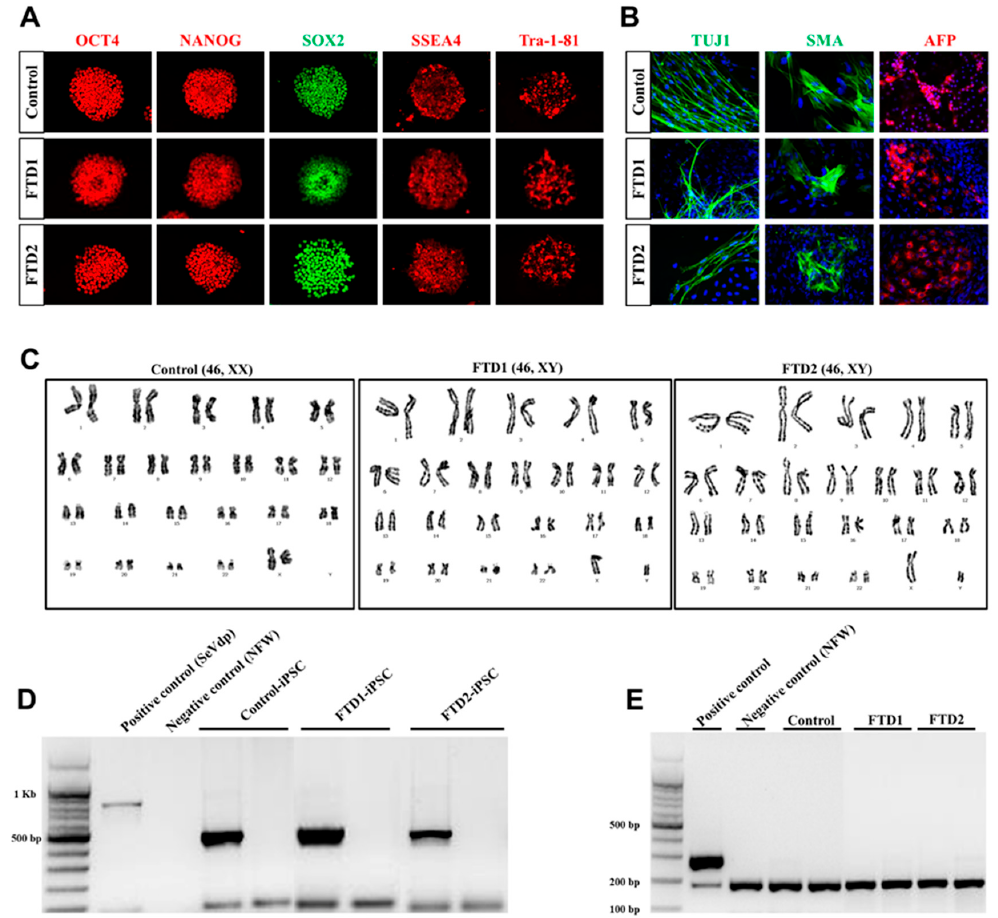
Figure 2. Generation and characterization of induced pluripotent stem cells (iPSCs) derived from bvFTD patients. ( A ) Expression of undi ff erentiated pluripotent stem cell markers in the established iPSC lines from control and two bvFTD patients. octamer-binding transcription factor-4 (OCT4, red), NANOG (red), SRY-box transcription factor 2 (SOX2, green), stage-specific embryonic antigen 4 (SSEA4, red) and tumor rejection antigen-1-81 (TRA-1-81, red). ( B ) Immunofluorescence analysis showing the di ff erentiation potential of iPSC lines into three germ layers, including ectoderm type III β -tubulin (TUJ1, green), mesoderm smooth muscle actin (SMA, green), and endoderm α -fetoprotein (AFP, red). Scale bar: 100 µ m. ( C ) Karyotype analysis of the control and bvFTD-patient-derived iPSC lines. ( D ) Sendai virus vector clearance was confirmed by reverse transcription polymerase chain reaction (RT-PCR) ( E ) Mycoplasma contamination was confirmed from genomic DNA using the PCR-based e-Myco TM VALiD mycoplasma detection kit (iNtRON,